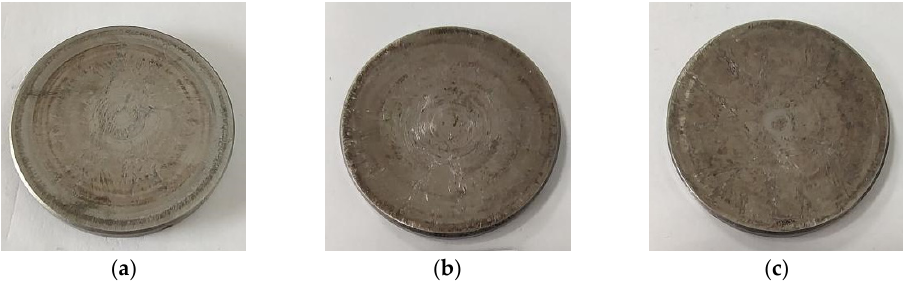
Figure 5. The macro photos of shims after the engine bench test: ( a ) 350 h, ( b ) 700 h, ( c ) 1000 h.